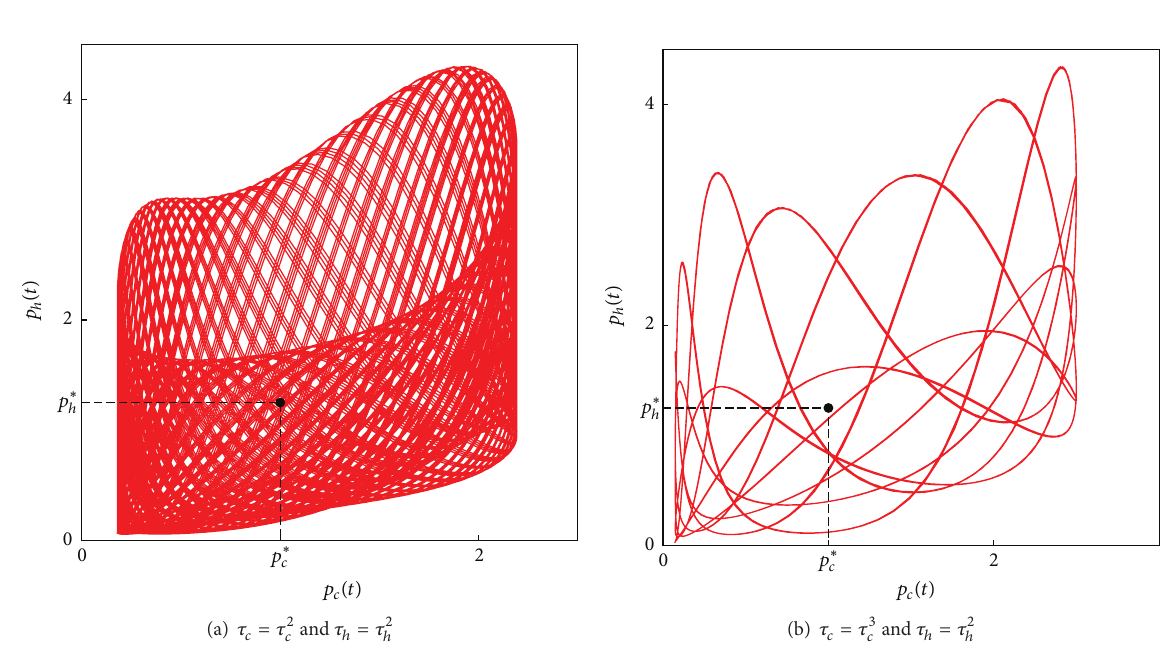
Figure 7: Bifurcation diagram with respect to 𝜏 𝑐 .